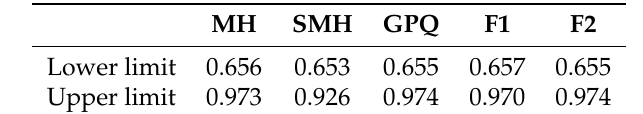
Table 6. 95% confidence intervals for the common odds ratio for the viral suppression example.